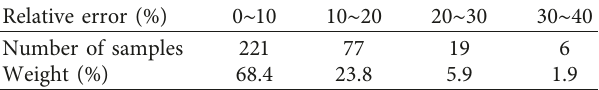
Table 7: Prediction errors of the modified chloride diffusion model (i.e., proposed model equations (14a) and (14b)).